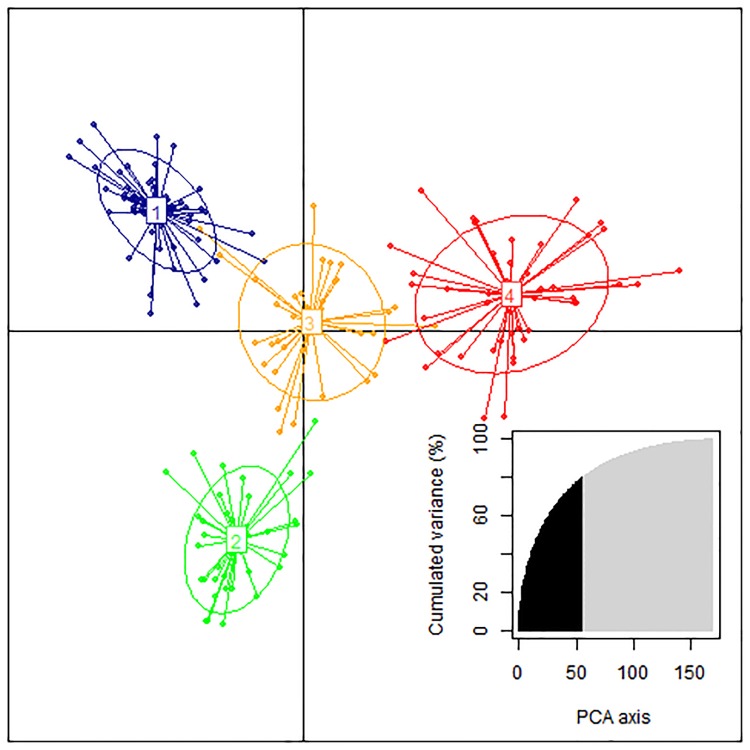
Population structure of the breeding panel as revealed by discriminant analysis of principal components.Each color represents a sub-population. The first 56 axes explained 80% of the total variance.